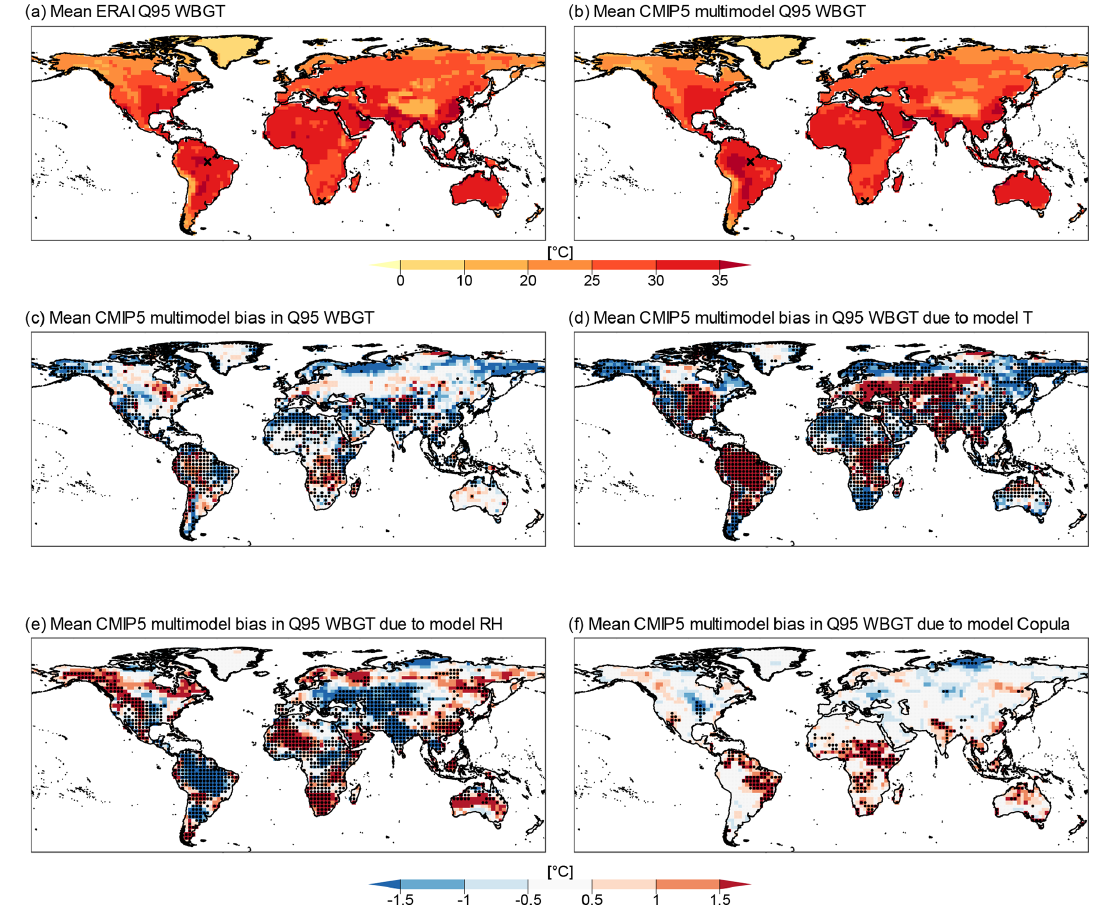
Figure 7. ERA-Interim (a) and CMIP multimodel mean (b) 95th quantile WBGT values. Mean CMIP5 multimodel bias in Q95 WBGT (c) and its decomposition into bias due to the T (d) , RH (e) , and copula (f) components of the models. Stippling indicates locations where more than 75% of CMIP5 model sample values lie outside the 95% confidence interval for ERA-Interim estimated based on bootstrap samples. Bias was calculated as (CMIP5 or transformation minus